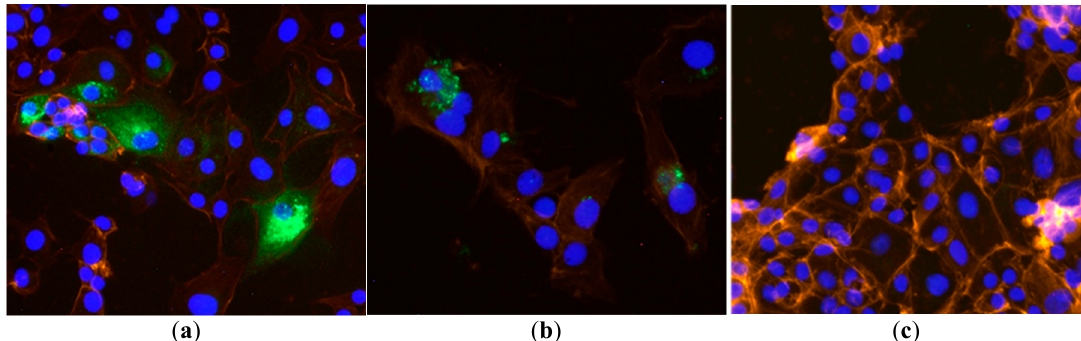
Figure 1. Indirect immunofluorescent staining of V76 cells was used to identify virus-infected cells. Cells infected with the MP-12 vaccine strain of Rift Valley fever virus ( a ), Rio Grande virus ( b ), or uninfected control cells ( c ) were grown on microwell slides prior to fixing with acetone. Fixed cells were stained with rabbit anti-RVFV nucleocapsid protein that was detected with green fluorescent labeled secondary antibody. Nuclei were detected with DAPI (blue), and actin filaments were detected with rhodamine-conjugated phalloidin. Intensely green-stained cytoplasmic granules were observed in MP-12- and RGV-infected cells, but absent from control cells. Images were captured at 40× magnification.